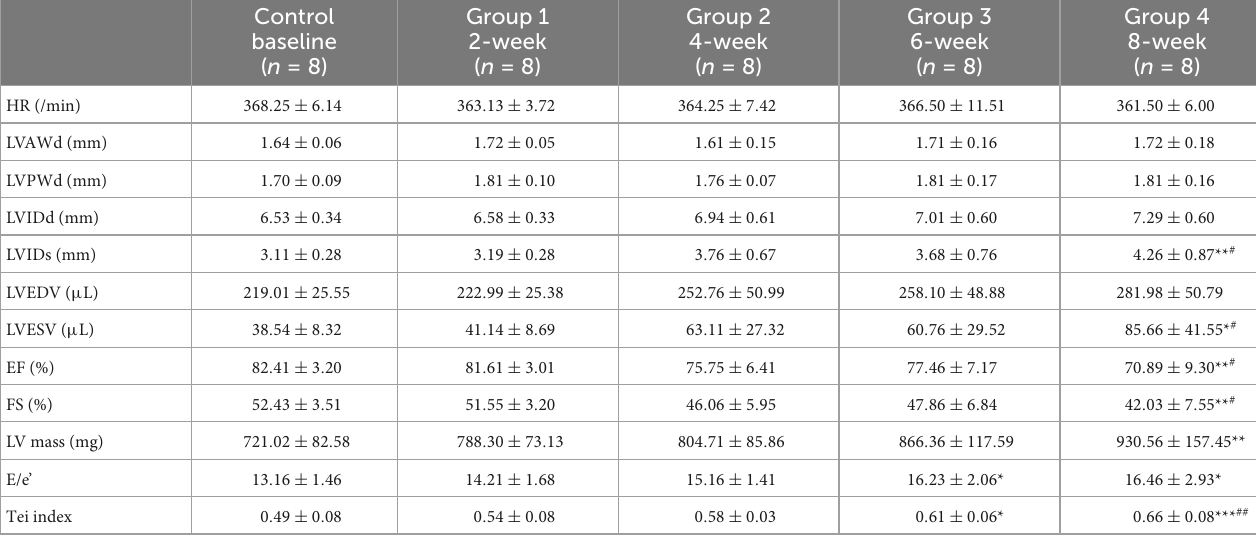
TABLE 1 Physiological and conventional echocardiography data for all subjects.